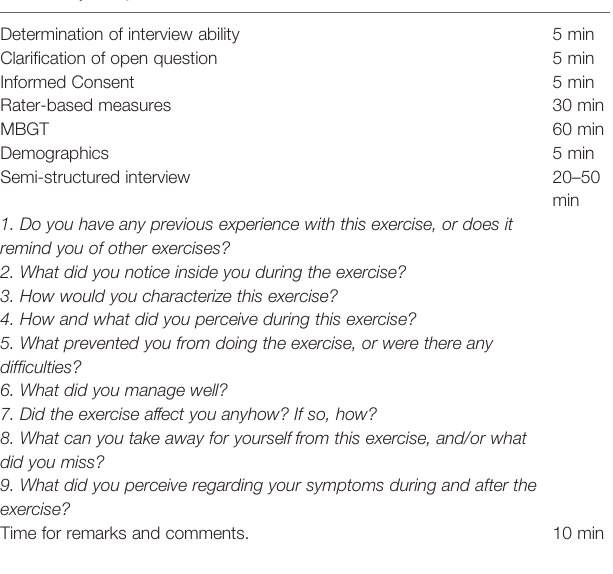
TABLE 2 | Study and interview schedule. Determination of interview